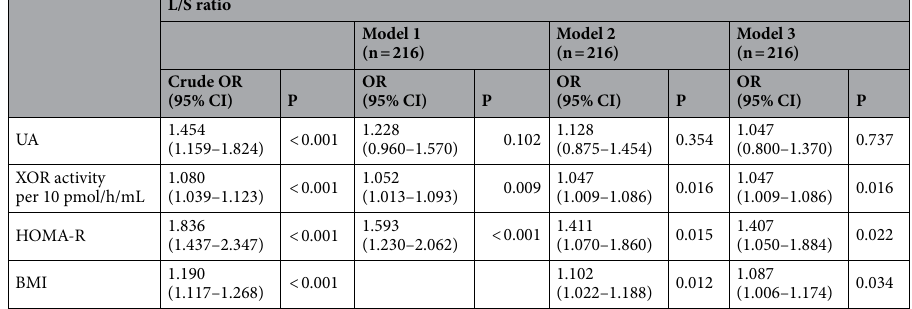
Table 4. Logistic regression analyses of the factors associated with liver-to-spleen (L/S) ratio. In model 1, an ordinal logistic regression analysis was performed with L/S ratio as the objective variable and serum uric acid (UA) levels, plasma xanthine oxidoreductase (XOR) activity, and homeostasis model assessment ratio (HOMA-R) as explanatory variables. In Model 2, body mass index (BMI) was added as an explanatory variable. In Model 3, logistic regression analysis was performed adjusting for age, gender, and presence of hypertension, dyslipidemia, and diabetes mellitus. OR, odds ratio; CI, confidence interval.